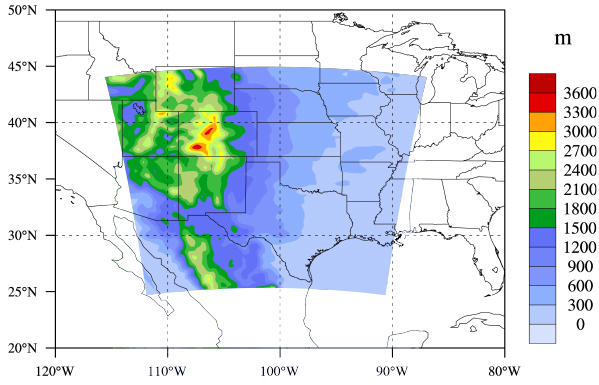
Fig. 2. WRF model domain (Southern Great Plain/SGP, 25–44 ◦ N and 112–90 ◦ W) with grid spacing of 25km. Shades indicate the terrain (Unit: